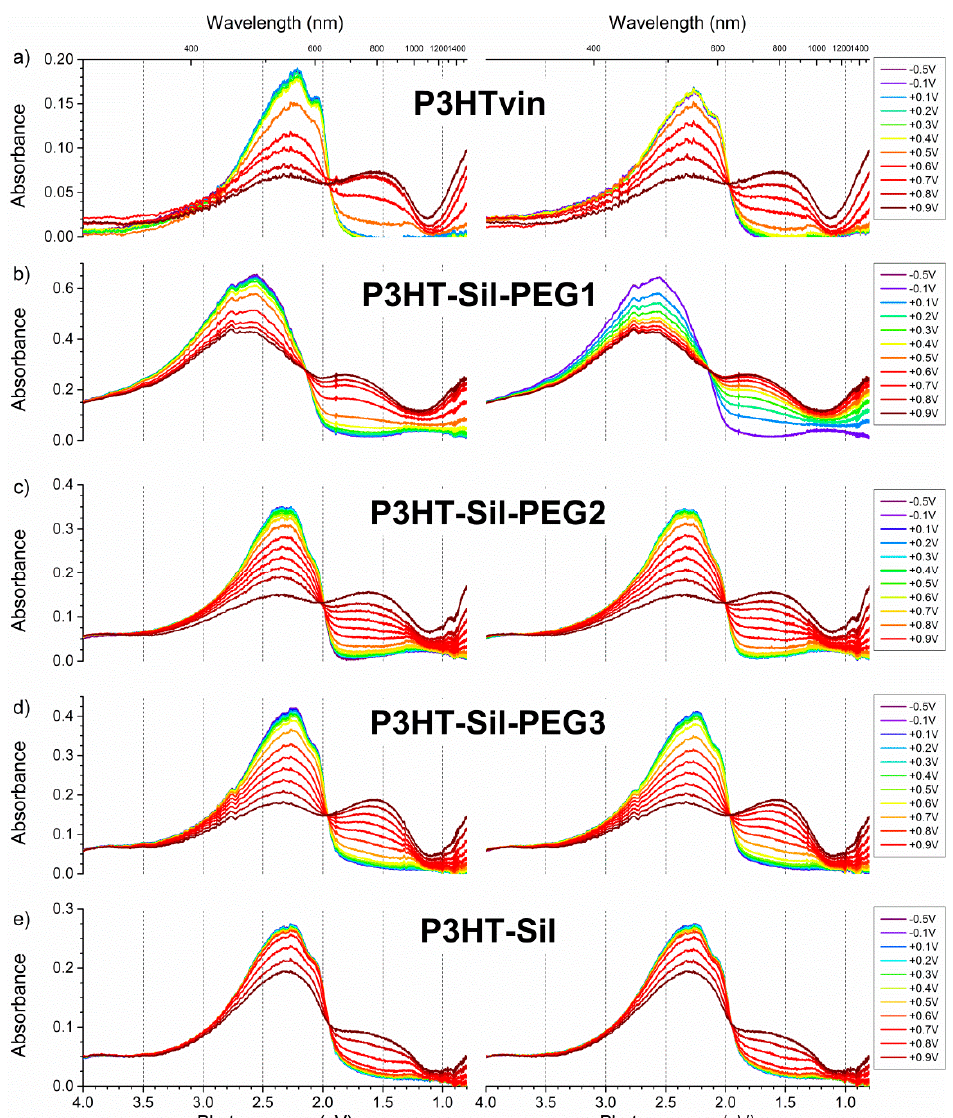
Figure 7. UV-Vis-NIR spectra recorded during the application of stepwise increasing ( left ) and decreasing ( right ) potential (vs. Ag/Ag+) to films of the investigated polymer and copolymer: ( a ) regioregular P3HT; ( b ) P3HT-Sil-PEG1; ( c ) P3HT-Sil-PEG2; ( d ) P3HT-Sil-PEG3; ( e ) P3HT-Sil deposited on ITO/quartz electrodes.